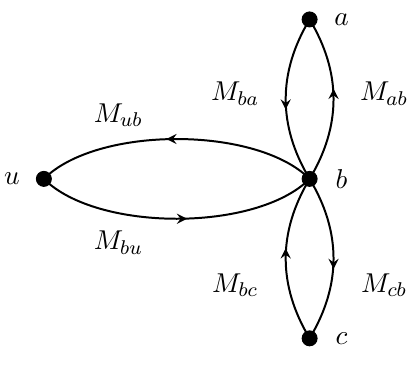
Figure 1 . Represents a quiver diagram where the arrows indicate the linear maps M ab , M ba , M bc , M cb , M bu , M ub and dots the spaces u , b , a , c on which they act.